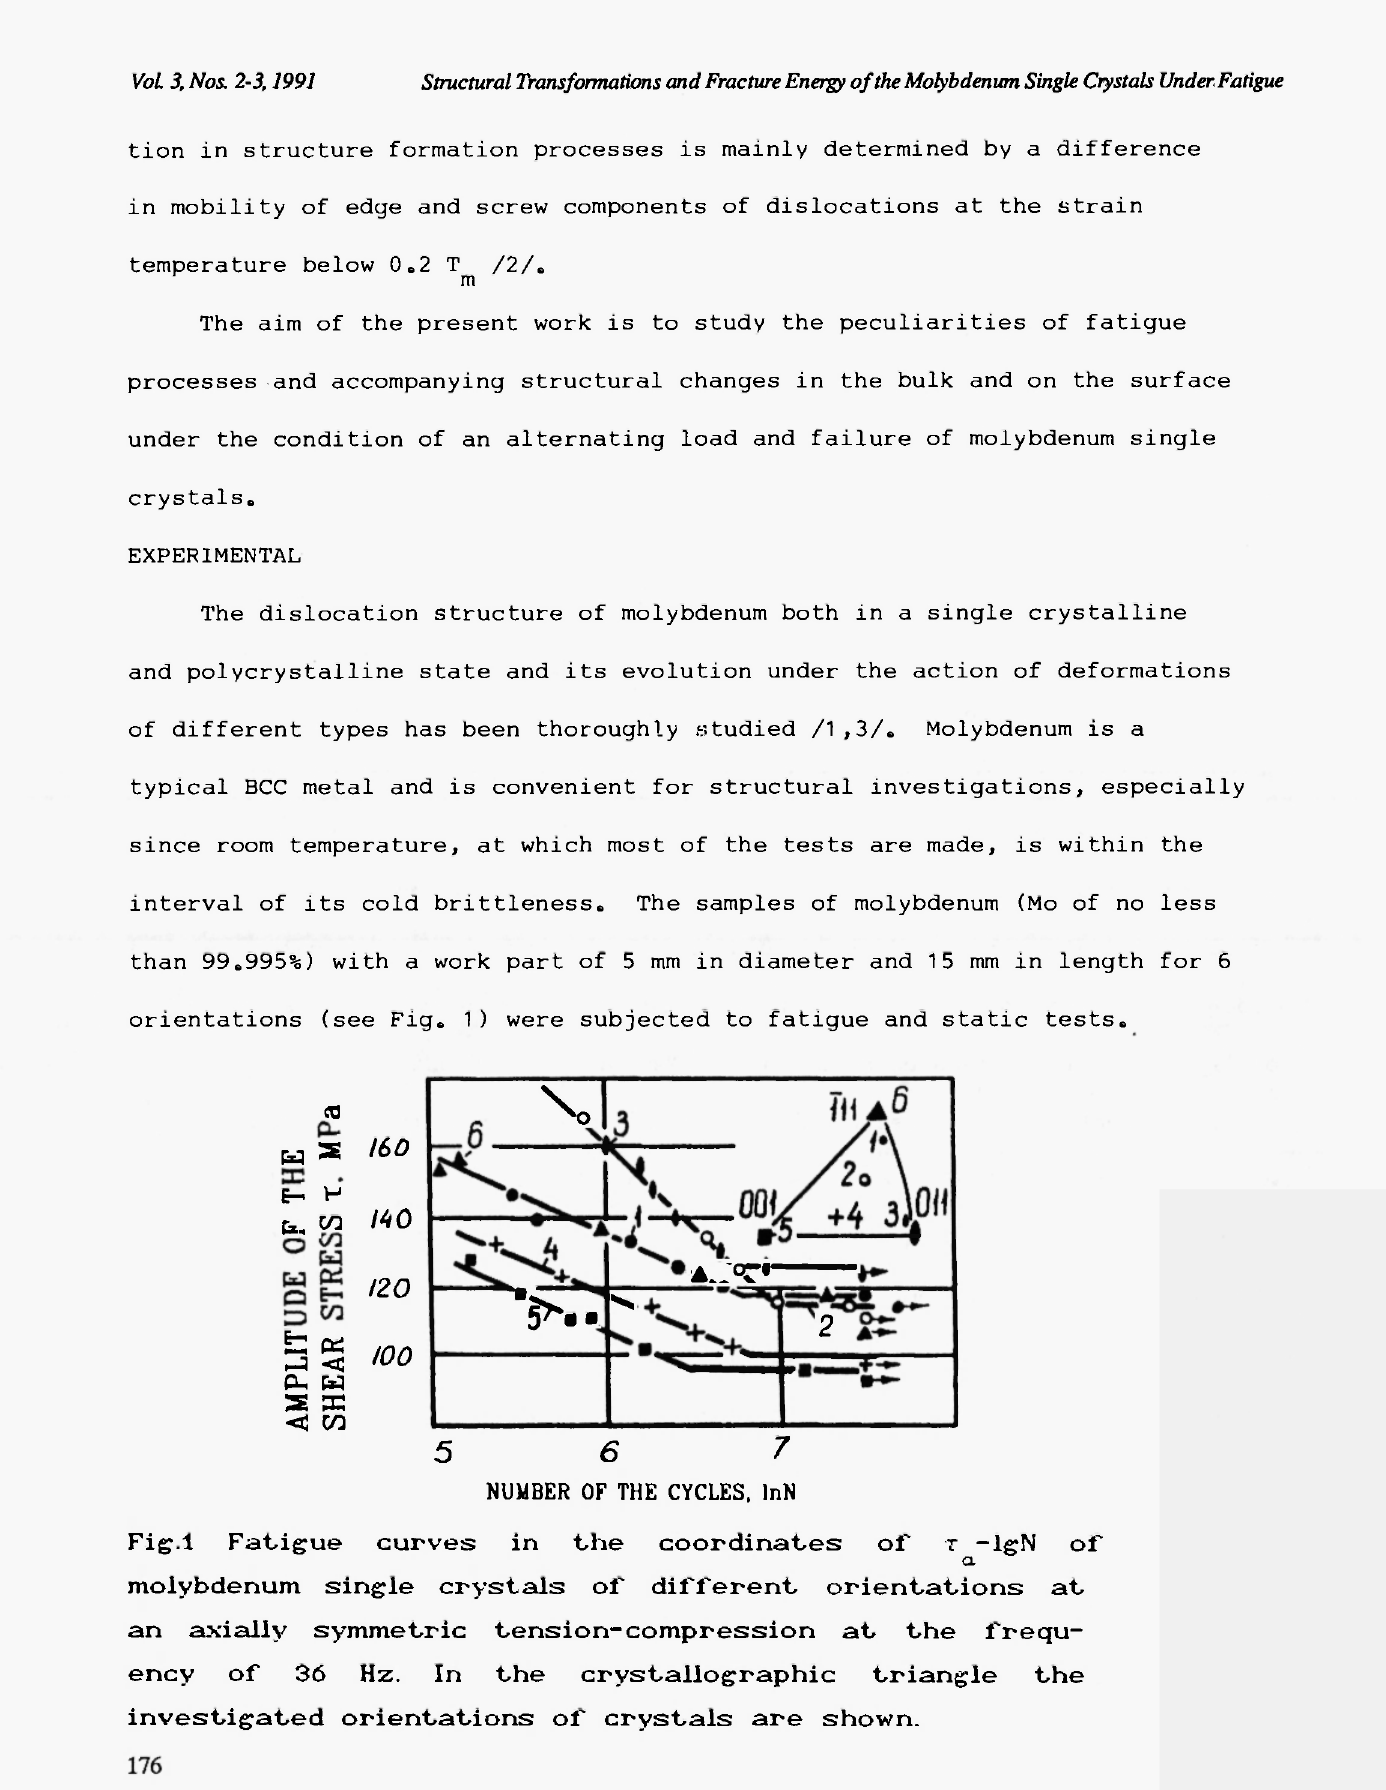
7 NUMBER OF THE CYCLES, InN Fig.l Fatigue curves in the coordinates of τ -IgN of α molybdenum single crystals of different orientations at an axially symmetric tension-compression at the frequ- ency of 36 Hz. In the crystallographic triangle the investigated orientations of crystals are